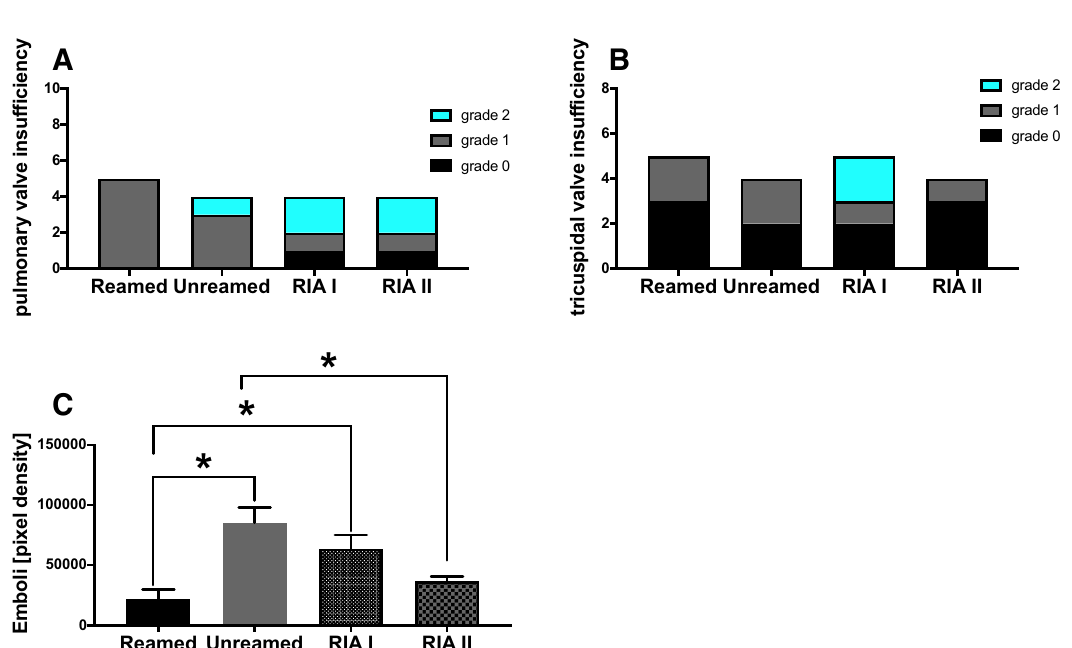
Figure 5. Valvular Insufficiency: ( A ) Number of detected pulmonary valve insufficiency measured by Echocardiography and graded in grade 0 to grade 2 by an experienced investigator 6 h after femur fracture. ( B ) Number of detected tricuspid valve insufficiency. ( C ) Amount of emboli (pixel density) detected in the animals during operative stabilization. n = 5 in each